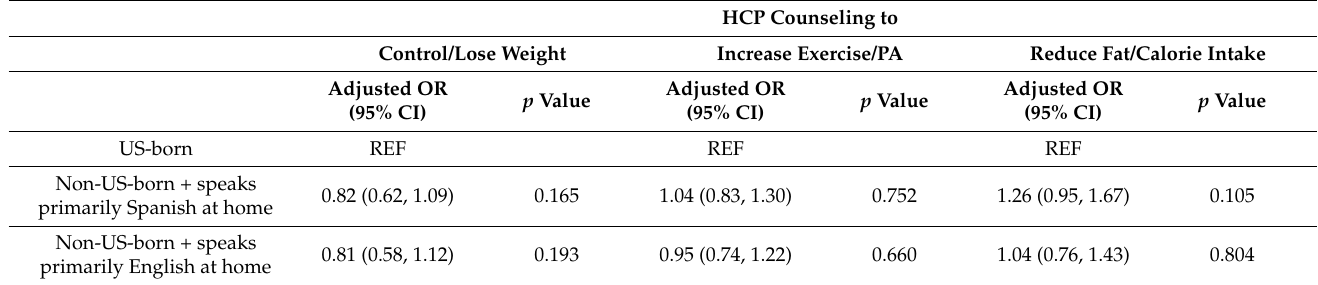
Table 2. Comparativeoddsratiosofreceivinghealthcareprovider(HCP)counselingbyacculturationlevel.